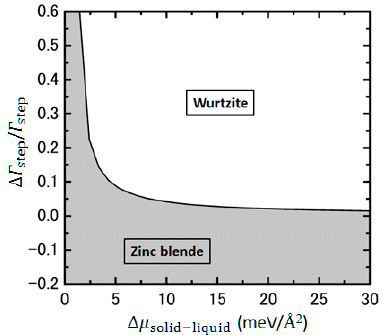
Figure 16. Phase diagram for crystal structure of InP NWs as functions of chemical potential difference between liquid and solid phases Δμ liquid-solid and normalized step energy difference between ZB and WZ structures ΔΓ step / Γ step , using the energy difference between ZB and WZ structures in bulk InP (6.8 meV/atom) [87] for interface energy per area between nucleus and nanowire top layer for WZ structure σ WZint . White and grey areas denote the stable regions for WZ and ZB structures, respectively.